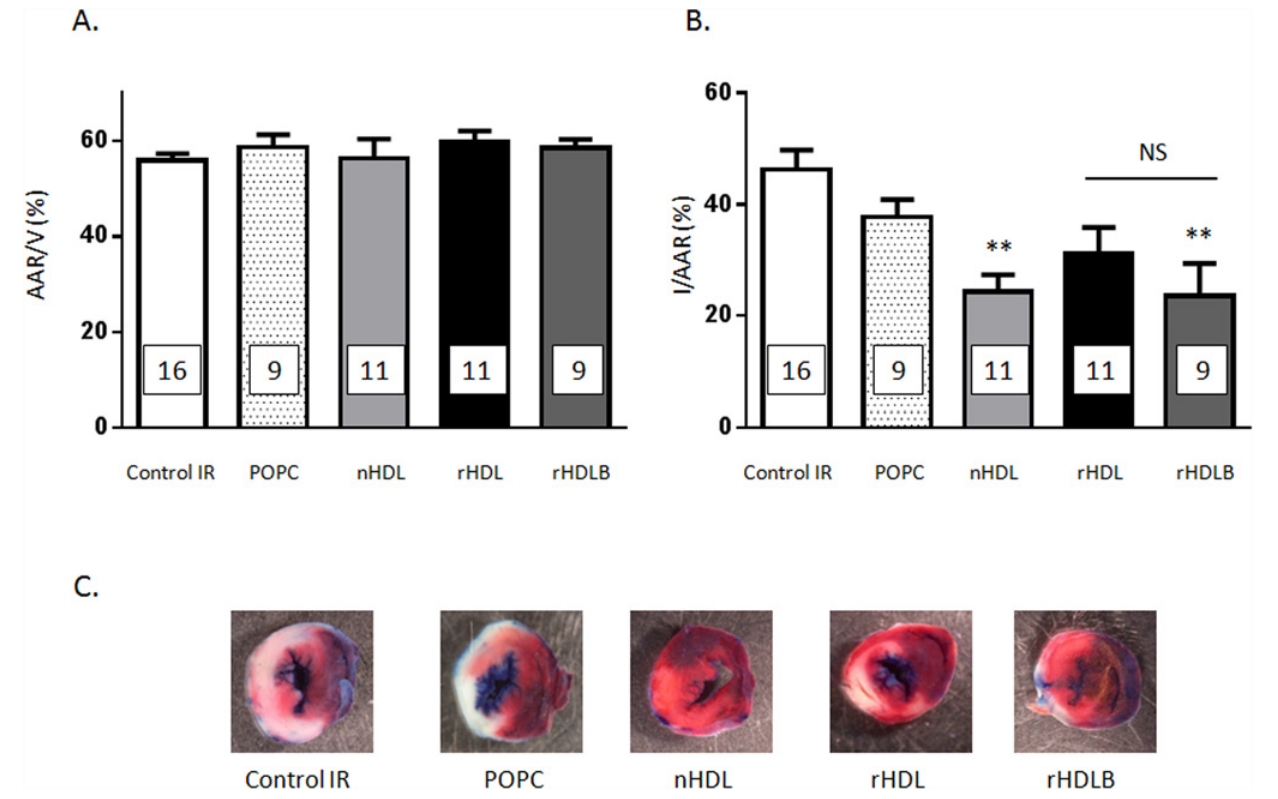
Fig 4. Post-ischemic treatment with HDL protects against ischemia reperfusion injury in vivo . Mice were submitted to LAD occlusion for 45min and hearts were reperfused for 24h. Mice were injected or not (control mice IR) with native HDL (nHDL), POPC, rHDL (apoA1+POPC) or rHDLB (apoAI + POPC + S1P) one minute before reperfusion. A. Quantification of area at risk (AAR) per ventricle surface. Data are mean ± SEM (n = 9 – 16 per group). B. Quantification of infarct size (IS) expressed in % of AAR. Data are mean ± SEM (n = 9 – 16 per group), ** p < 0.01, vs IR, using one-way ANOVA combined with Tukey multiple comparisons post-hoc test. C. Representative images of TTC stained middle heart sections of control or treated mice.